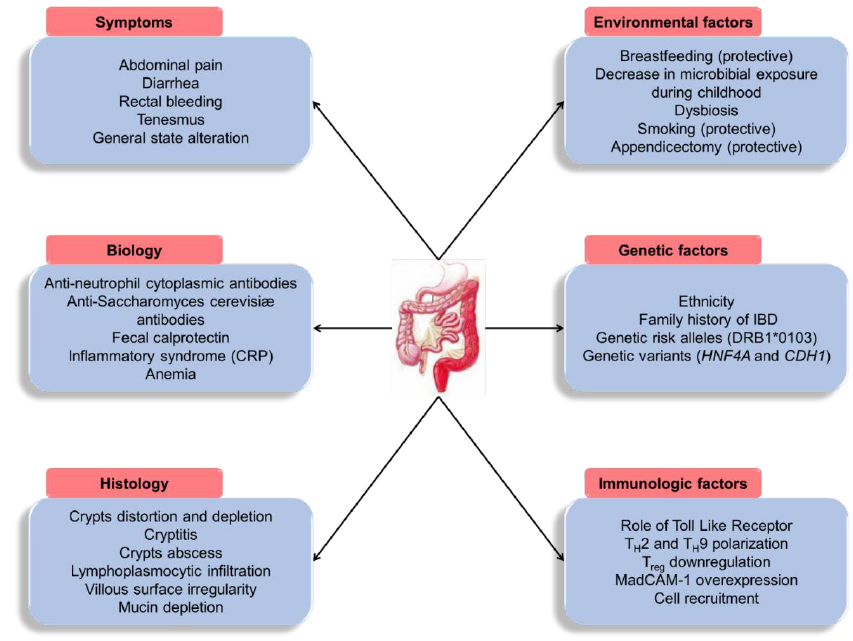
Figure 1. Main characteristics and risk factors of ulcerative colitis. CRP: C-reactive protein; IBD: Inflammatory bowel disease; T H , T helper cell.